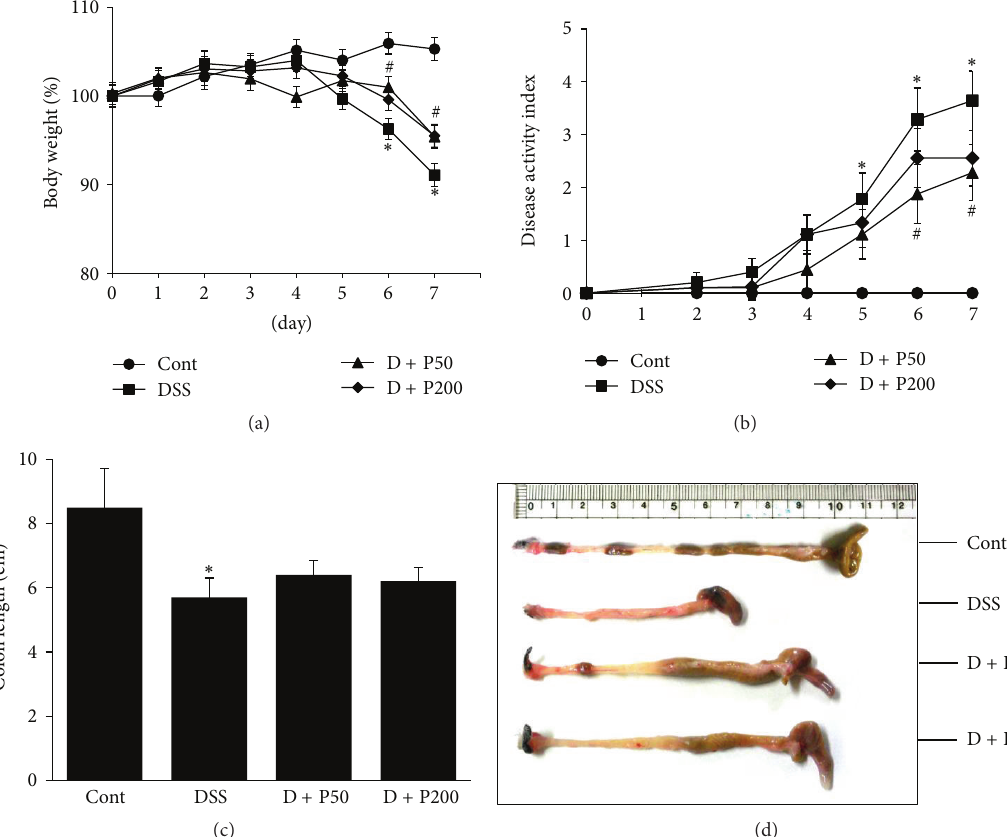
Figure 1: 𝛾 -PGA attenuates clinical signs in mice with DSS-induced colitis. (a) Changes in the body weights and (b) clinical scores of 𝛾 -PGA- treated mice and control mice administered 3% DSS were monitored every day. Body weight values are expressed as a percentage of body weight on day 0. (c) Colons were obtained from mice 7 days after commencement of DSS administration, and their lengths were measured. (d) Macroscopicfeaturesofthecolons.Controlgroup(withoutDSS;Cont),3%DSSadministrationgroup(DSS),3%DSSwith 𝛾 -PGAat50mg/kg body weight per day (D + P50), 3% DSS with 𝛾 -PGA at 200mg/kg body weight per day (D + P200). Data shown are from 3 independent experiments and are expressed as mean ± SD ( 𝑛 = 8 per group). ∗ 𝑃 < 0.05 , DSS versus Cont; # 𝑃 < 0.05 , D + P50 and D + P200 versus DSS. models are routinely used to represent the